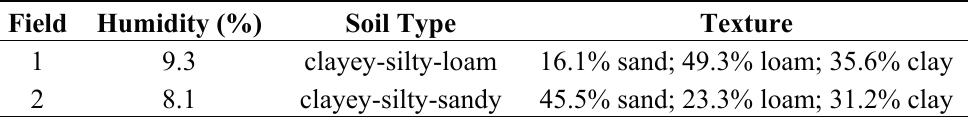
Table 2. Properties of the soils corresponding to the trial